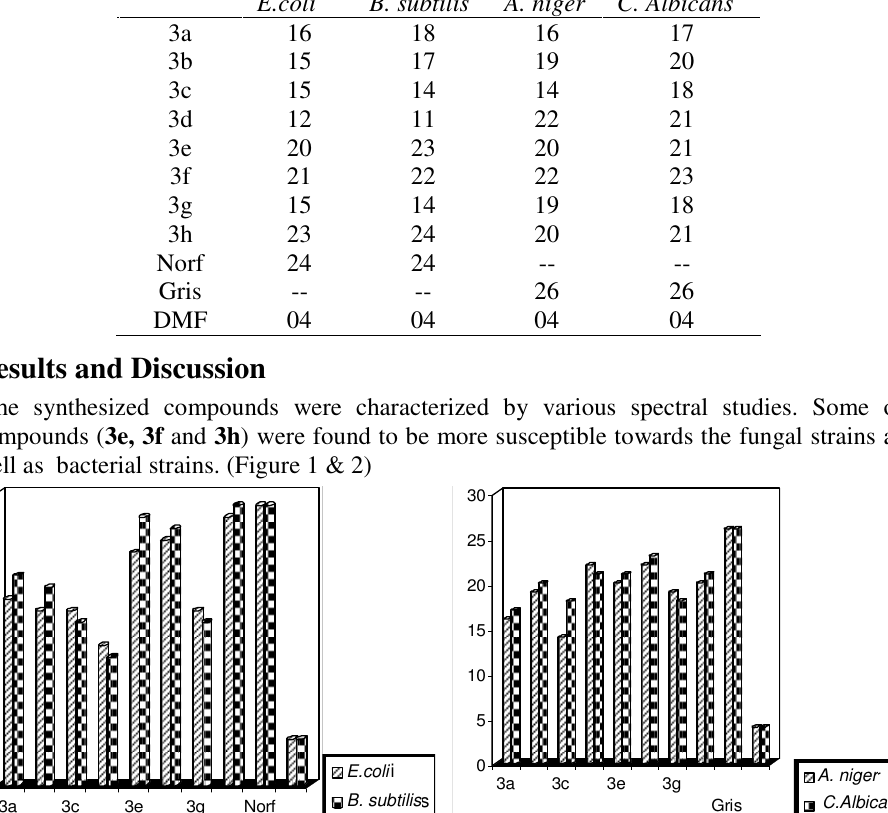
Table 3. Anti-microbial activities of compounds. Antibacterial